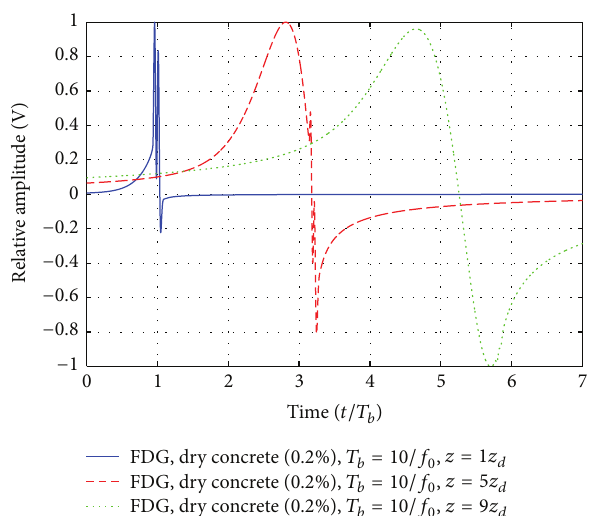
Figure 3: Baseband rectangular and FDG pulses in time domain.